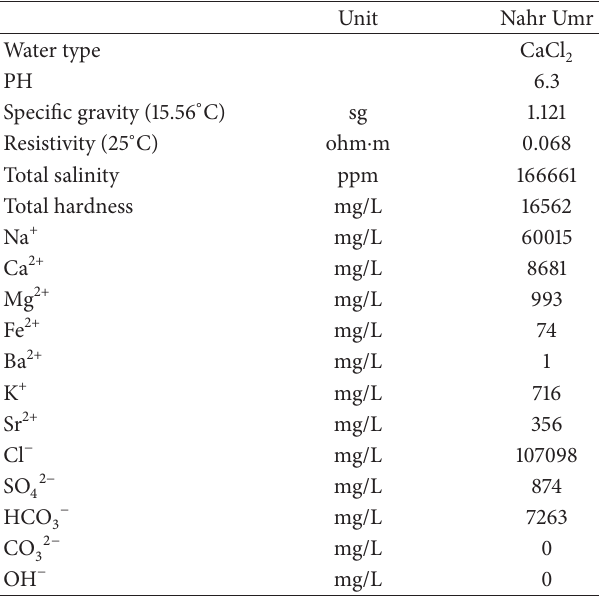
Table 2: The formation fluid properties of Halfaya